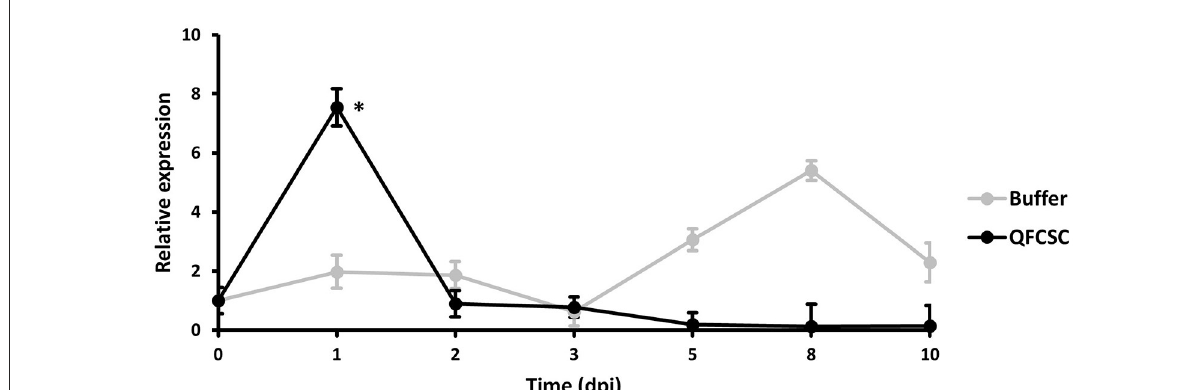
FIGURE1 Relative expression of TaMYC4 in wheat cultivar Alpowa inoculated with buffer (control) and the Puccinia graminis f. sp. tritici ( Pgt ) pathogen (race QFCSC). Alpowa cultivar were inoculated with Pgt urediniospore at 2-leaf stage. RNA samples were extracted from the leaf samples collected at seven time points. Real-time PCR was used to quantify transcript abundances of TaMYC4 genes in both buffer and Pgt inoculated samples. Expression of TaMYC4 genes at each time point was computed relative to the level at 0-dpi. Error bars represent standard deviation computed as the square root of pooled variance between groups and * denote statistical significance at the P ≤ 0.05 levels calculated between each time point compared with 0